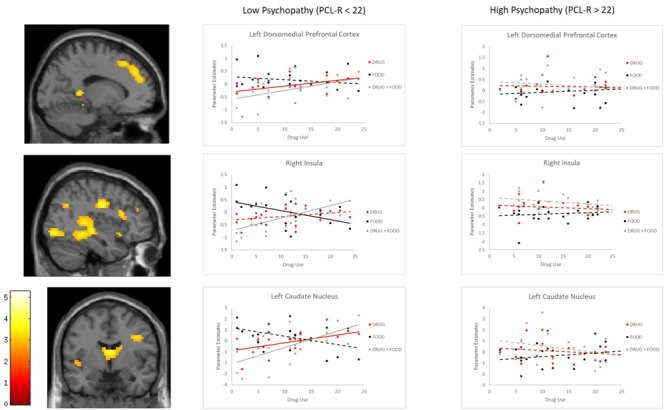
Correlations between parameter estimates and Major Drug Use among Dependent participants with high and low PCL-R scores. Scatterplots demonstrate correlations between Major Drug Use and parameter estimates of neural activity in response to DRUG and FOOD videos, as well as their calculated difference in activity (DRUG > FOOD). Solid lines indicate significant correlations at p < 0.05. Dotted lines indicate non-significant relationships. Brain images are displayed at a significance threshold of p(uncorr) < 0.005, with an extended cluster threshold of k = 30.